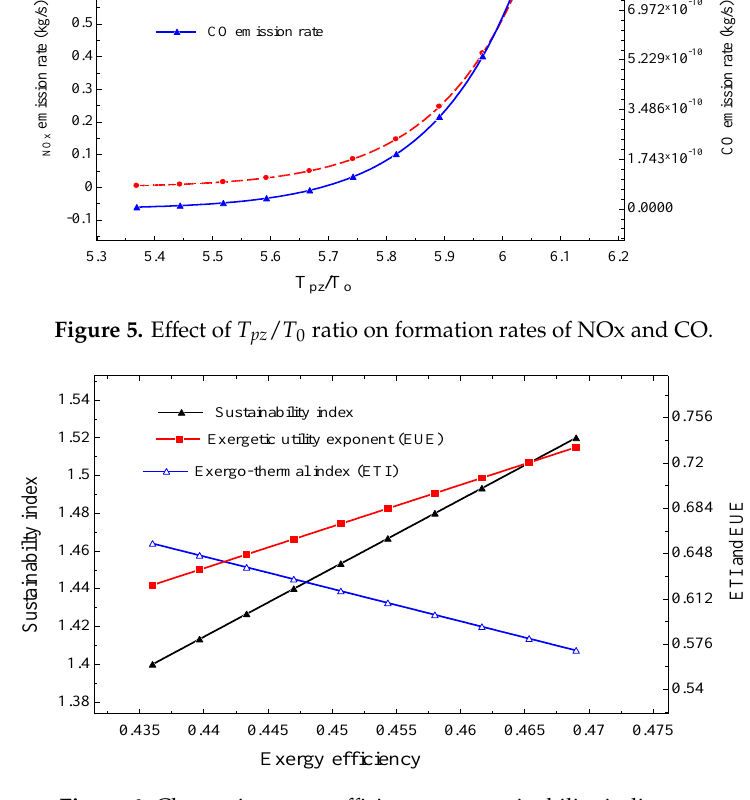
Figure 6. Change in exergy efficiency on sustainability indicators.